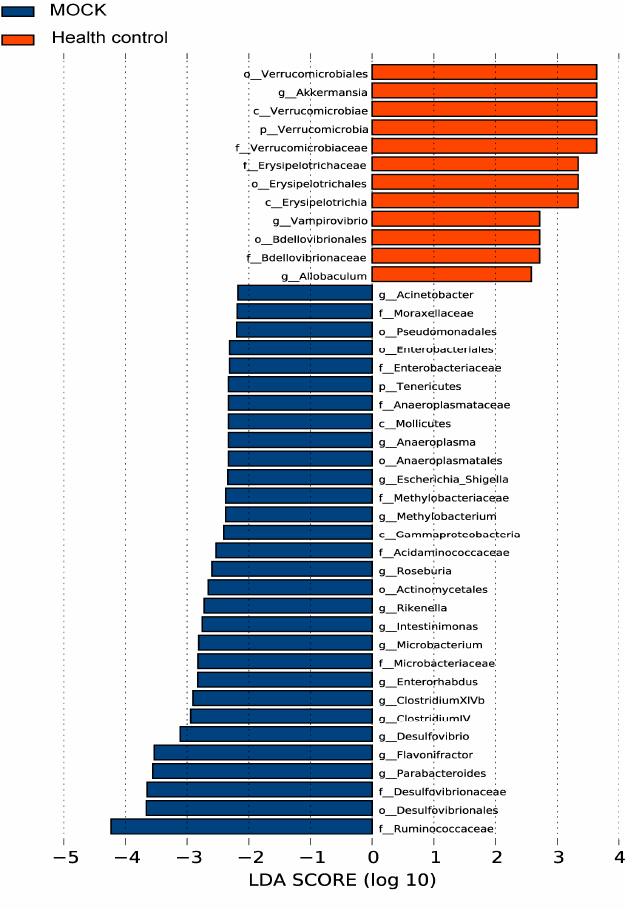
Figure 8. The comparison of the fecal microbiome project of MOCK group to other groups. All data of the taxonomic information in four groups were analyzed with Metaphlan2 program, the cladogram ( a ) was derived from LEfSe analysis (http://huttenhower.org/galaxy/). Linear discriminant analysis (LDA) of the fecal microbiota in MOCK group and PB group ( b ), MOCK group and PB/ProBio group ( c ), MOCK group and Health control ( d ). A p -value of <0.05 and a score ≥ 2.0 were considered significant in Kruskal–Wallis and pairwise Wilcoxon tests, respectively. The horizontal straight line in the panel indicates the groups